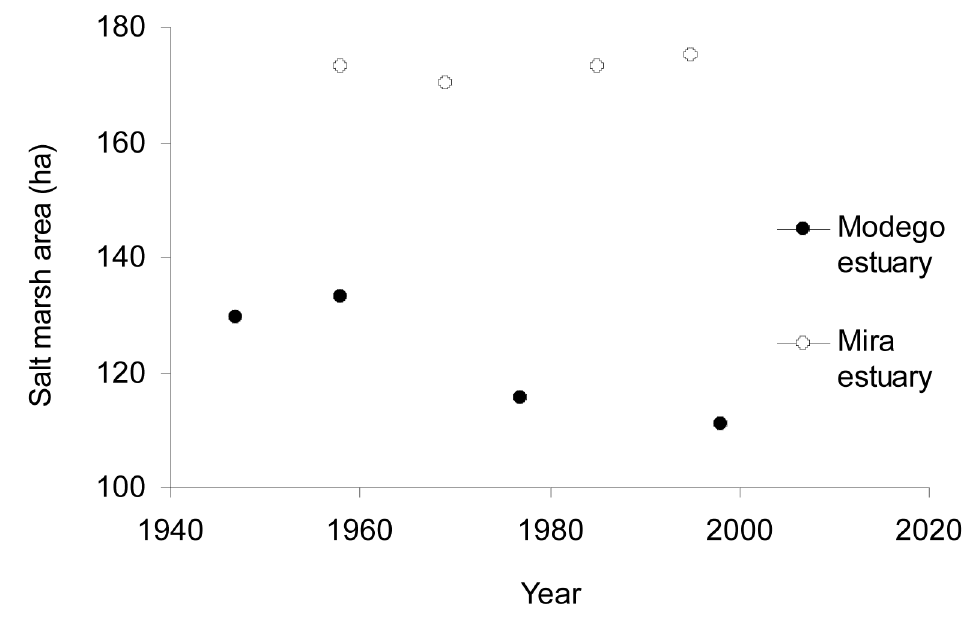
Fig. 5. Salt marsh area evolution in each estuary.